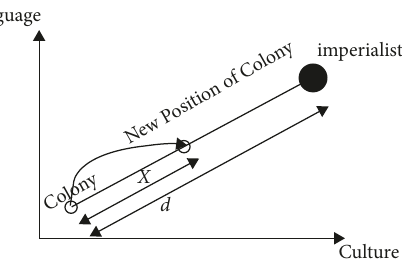
Figure 2: Changing position of colonies to their related